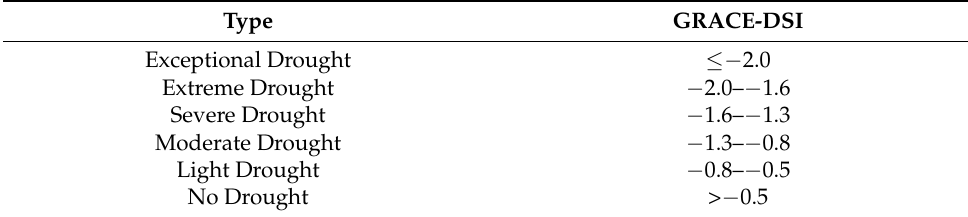
Table 1. GRACE-DSI drought grades